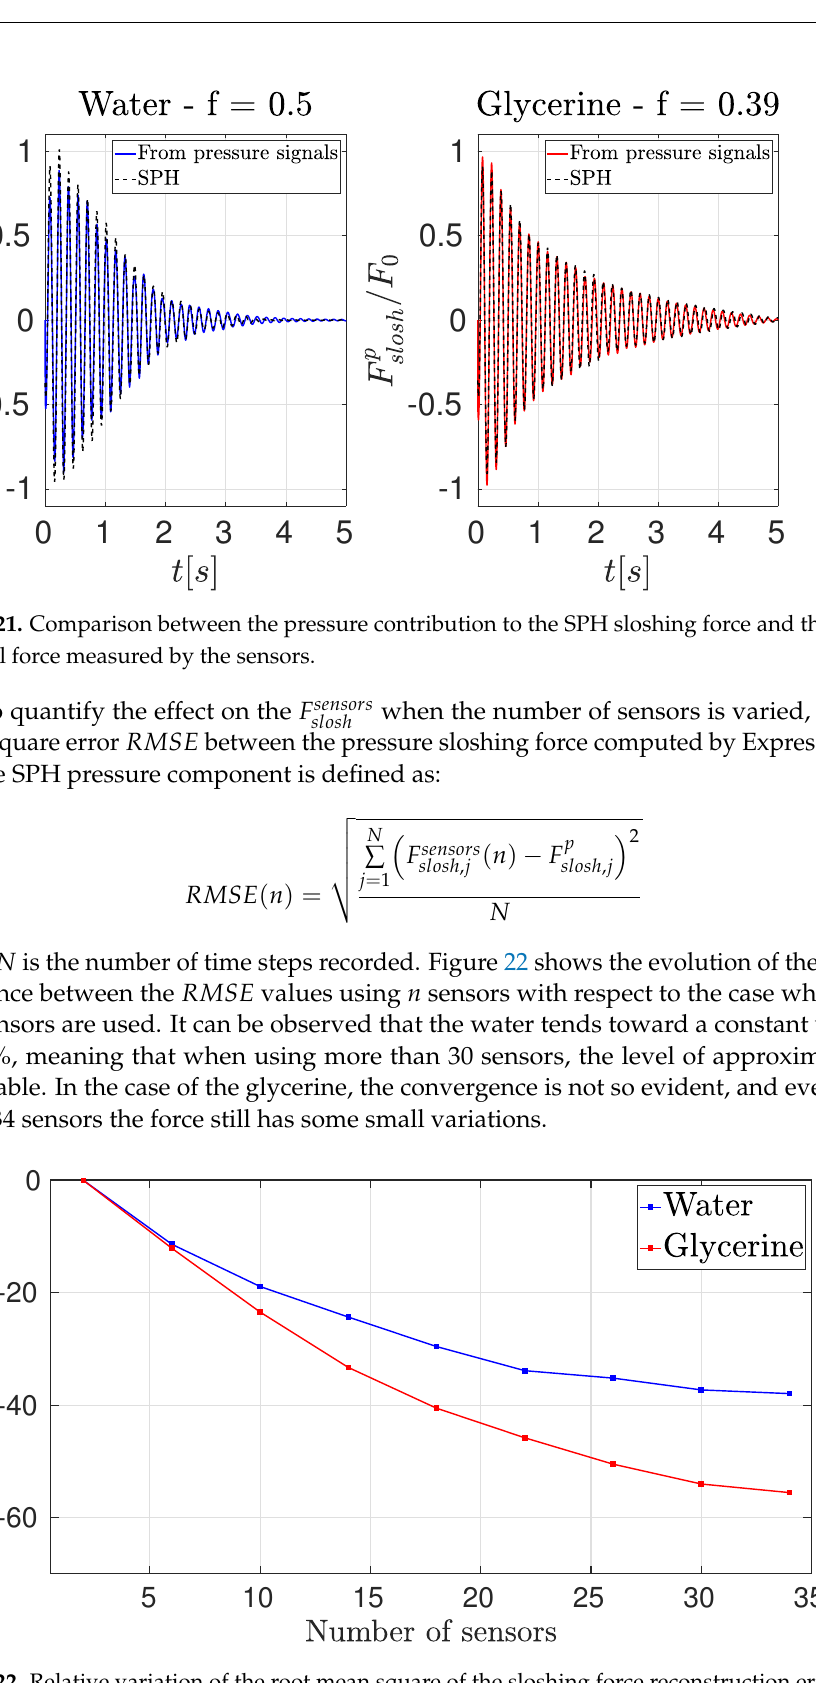
Figure 22. Relative variation of the root mean square of the sloshing force reconstruction error when the number of pressure sensors is